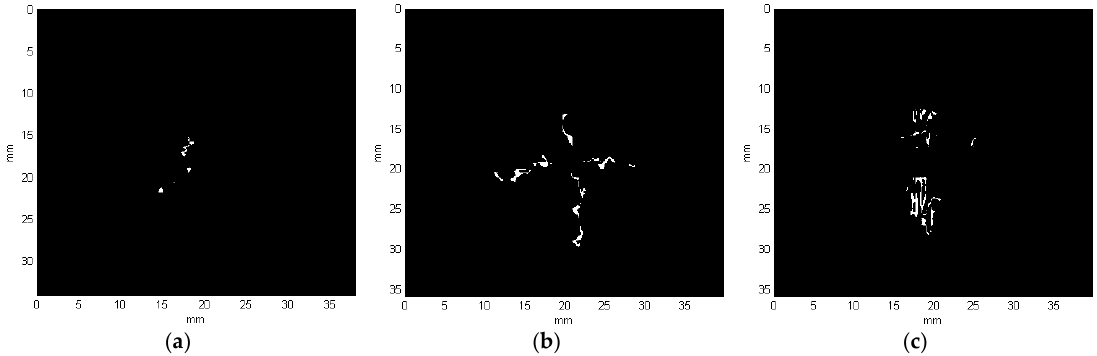
Figure 20. Binary results obtained for the representative X-ray CT slice cases: ( a ) no. 18; ( b ) no. 20; ( c ) no. 99.